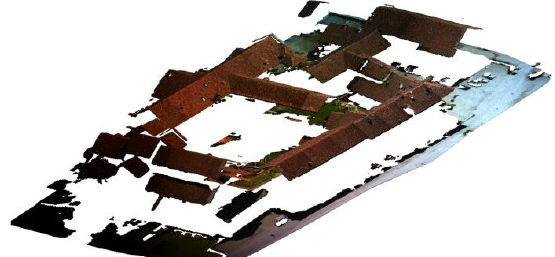
Figure 19. Point cloud extracted using MicMac